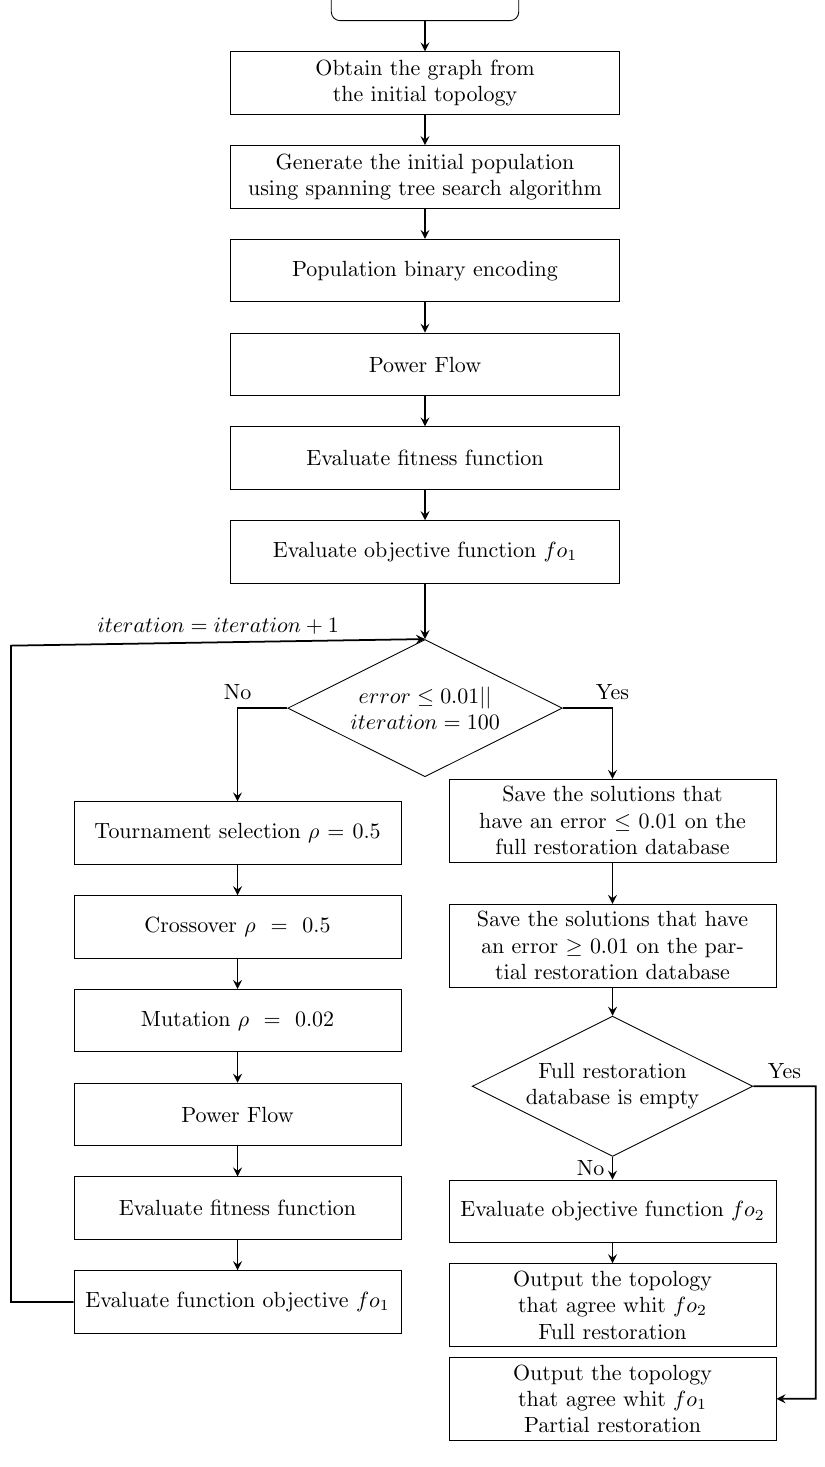
Figure 6. Flowcharts for the proposed GA